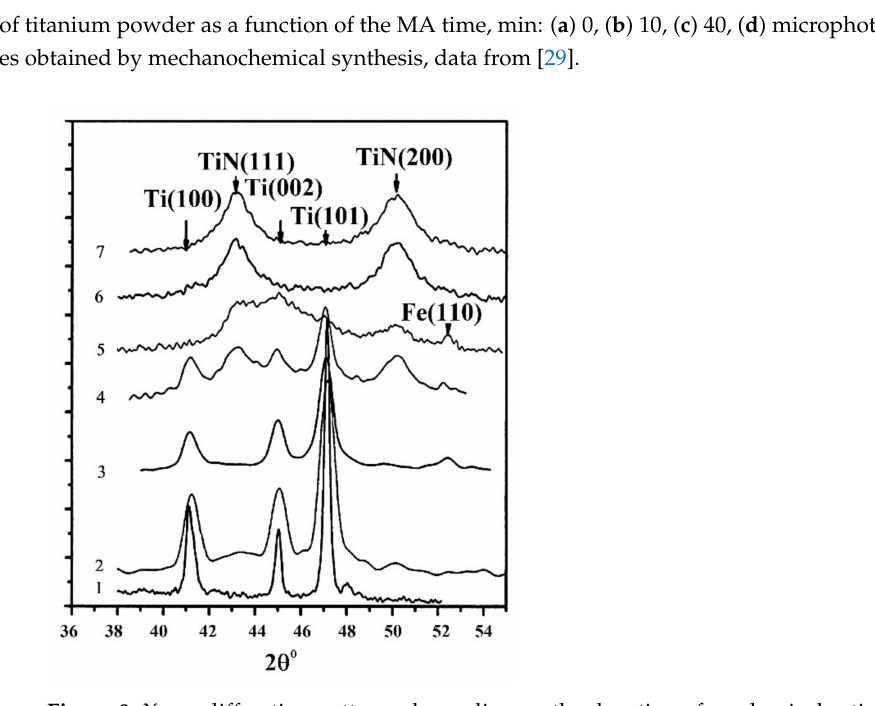
Figure 9. X-ray diffraction patterns depending on the duration of mechanical activation in a